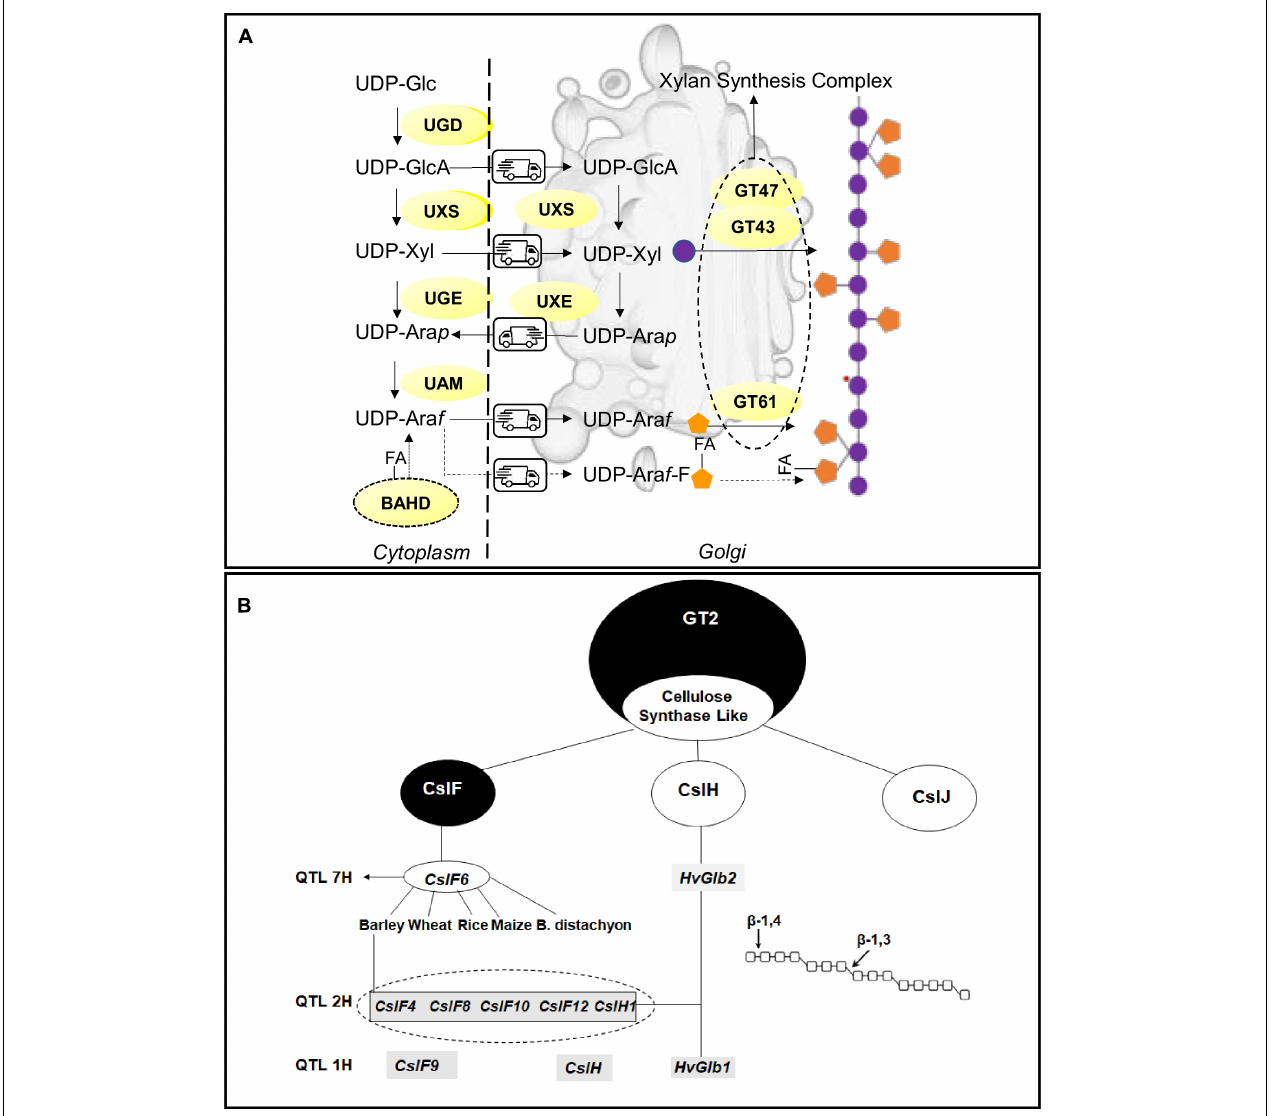
FIGURE 2 | Biosynthetic pathways and key enzymes for (A) arabinoxylans and (B) β -glucans. (A) Schematic representation of arabinoxylan synthesis involving the cytoplasm and Golgi apparatus; nucleotide sugars: Xyl, Xylose; Ara, Arabinose; GlcA, Glucuronic acid; UDP-L-Arap, UDP-L-arabinopyranose; UDP-L-Araf, UDP-L-arabinofuranose. UDP-sugars converting enzymes UAM, UDP-Ara mutase; UGD, UDP-Glc 6-dehydrogenase; UGE, UDP-glucose 4-epimerase; UXE, UDP-Xyl 4-epimerase; UXS, UDP-Xyl synthase; BAHD acyl transferase FA, Ferulic acid. GT47, GT43, GT61 Glycosytransferases. (B) Key Enzymes involved in β -glucan synthesis in cereals. The figure shows the main QTLs and associated candidate genes for β -glucan synthesis identified in cereals. The dotted circle underlines the cluster of CslF plus CslH1 genes identified in